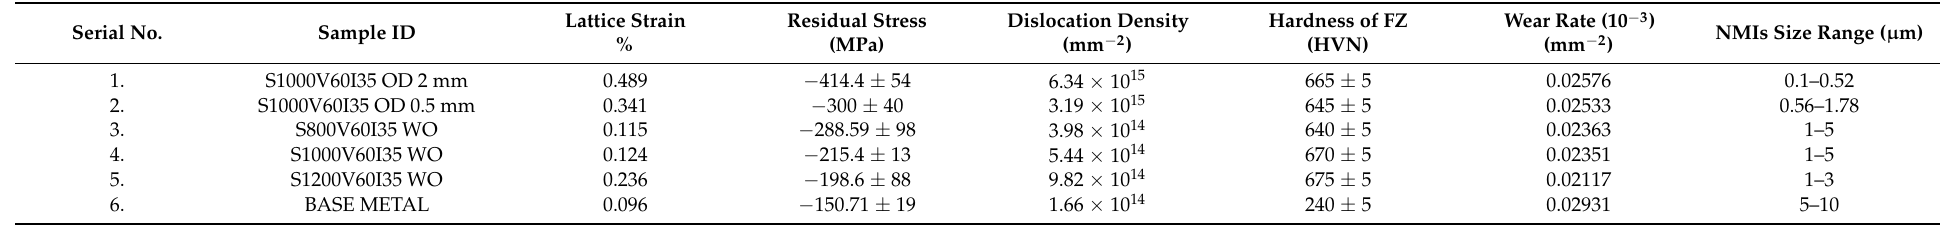
Table 4. Residual stress, lattice strain and dislocation density, hardness, wear rate and NMIs size calculation of fusion zone for different sample conditions. Serial